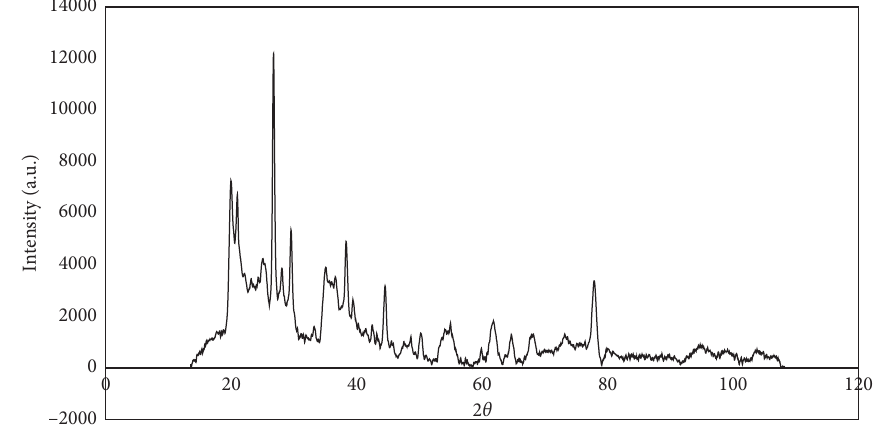
Figure 4: XRD analysis.